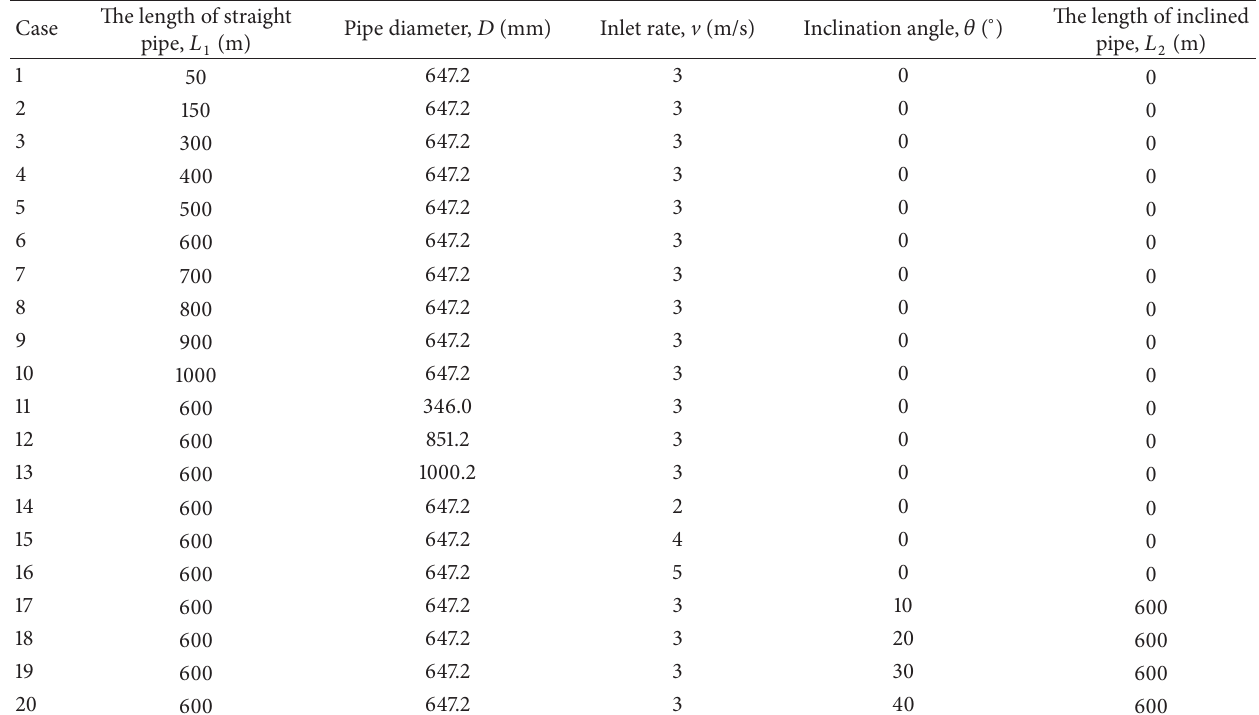
Table 1: Simulation